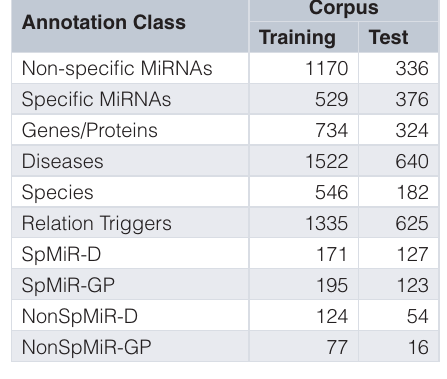
Table 1. Inter-annotator agreement scores for the test corpus.